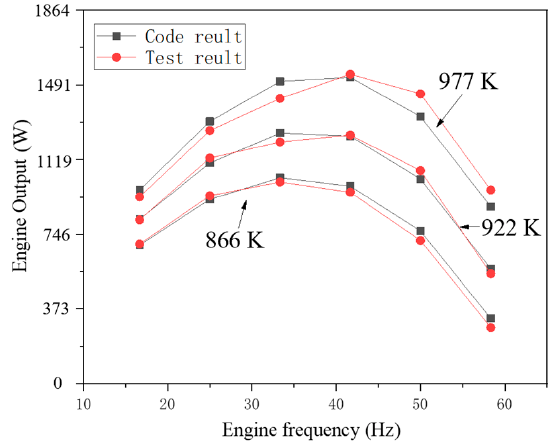
Figure 11. Comparison between the calculated and experimental value of GPU-3 Stirling engine.